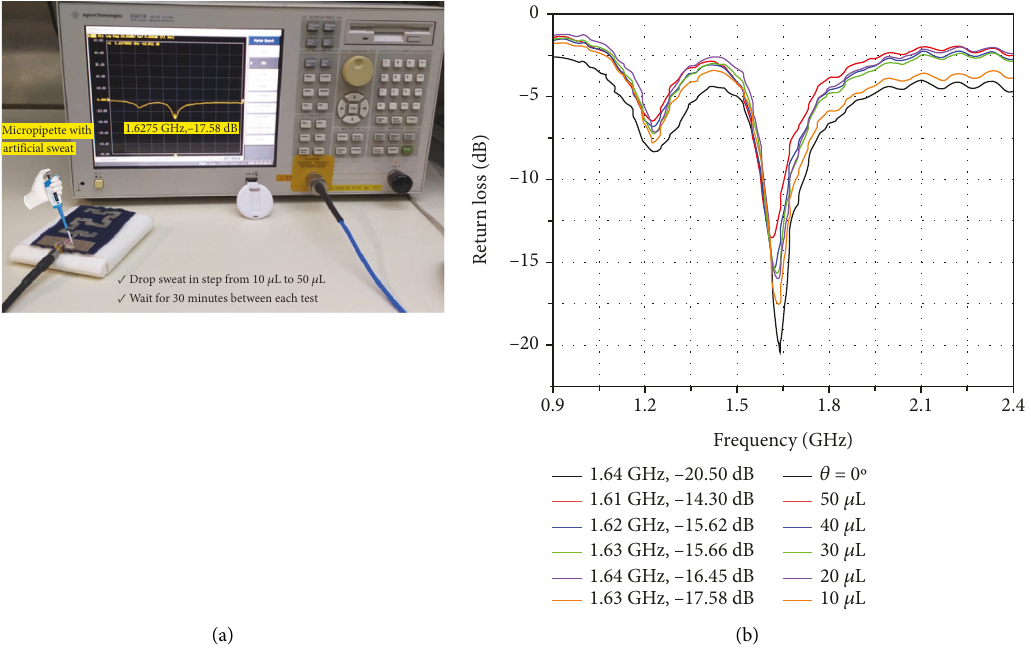
Figure 10: (a) A snapshot of the measurement setup in the wet condition of the antenna; and (b) return loss versus frequency plot when the antenna gets wetted with different quantities of artificial